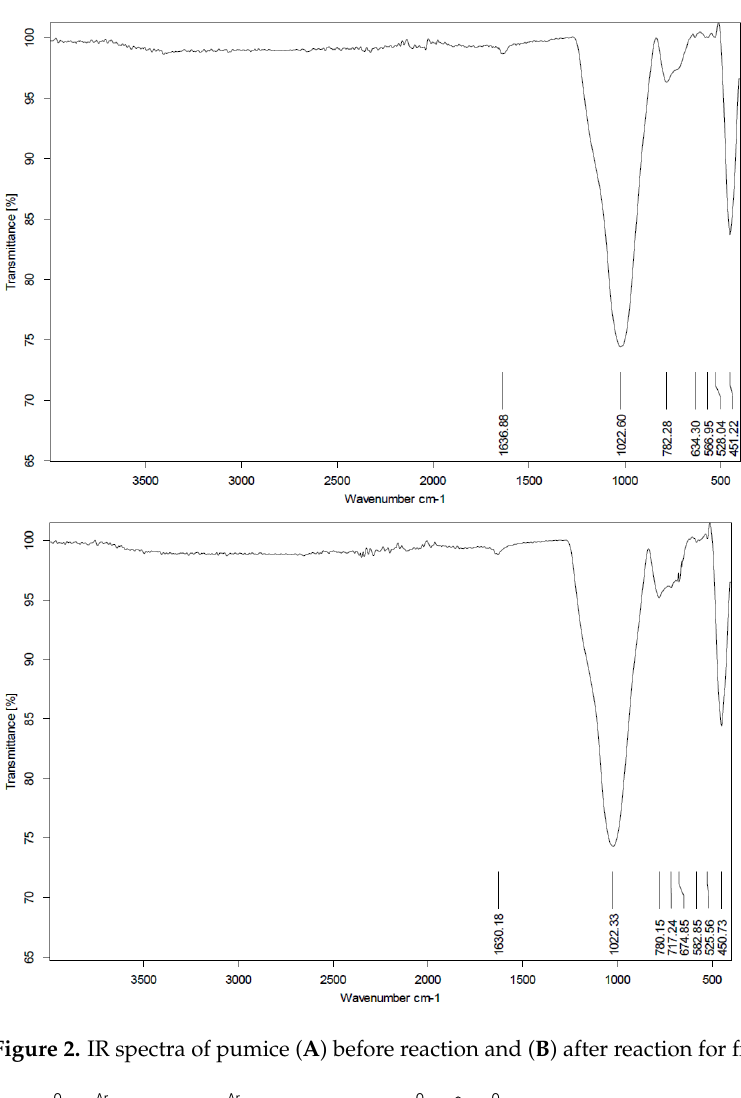
Figure 2. IR spectra of pumice ( A ) before reaction and ( B ) after reaction for five-time reaction cycles.